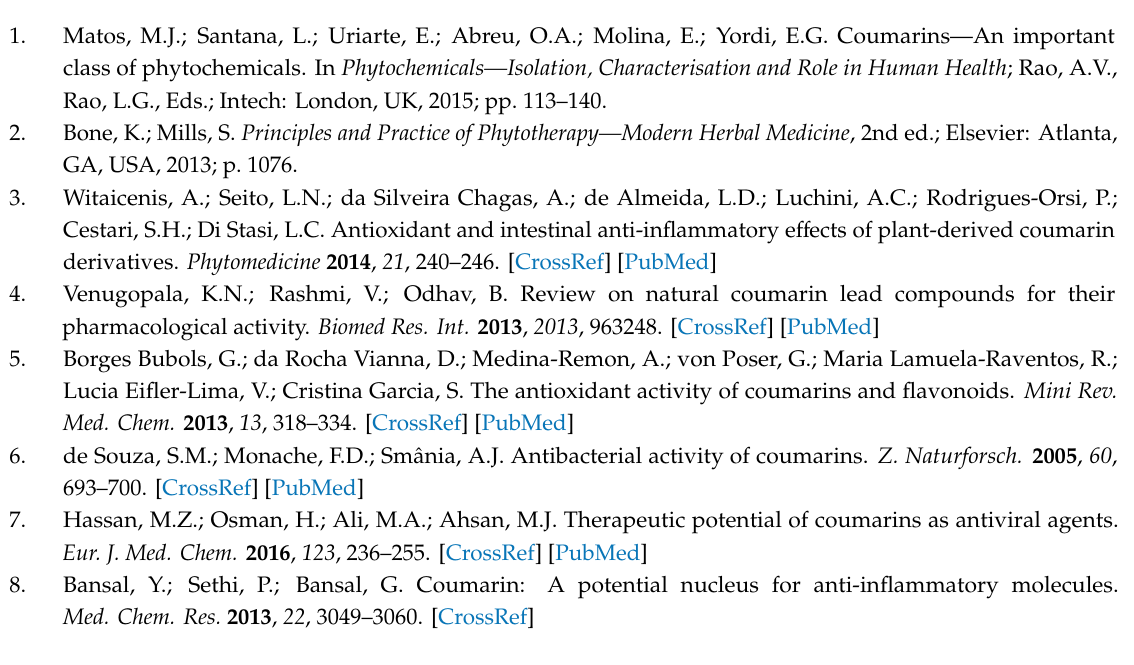
Supplementary Materials: The following are available online, Figure S1: 1 H NMR spectrum of compound C1 (600 MHz, CD 3 OD); Figure S2: 13 C NMR spectrum of compound C1 (150 MHz, CD 3 OD); Figure S3: 1 H- 13 C HSQC 2D NMR correlation spectroscopy of compound C1 (600 MHz / 150 MHz, CD 3 OD); Figure S4: 1 H- 13 C HMBC 2D NMR correlation spectroscopy of compound C1 (600 MHz / 150 MHz, CD 3 OD); Figure S5: 1 H- 1 H COSY 2D NMR correlation spectroscopy of compound C1 (600 MHz, CD 3 OD); Figure S6: HRESIMS spectrum of compound C1 (negative ion mode); Figure S7: 1 H NMR spectrum of compound C2 (400 MHz, DMSO-d 6